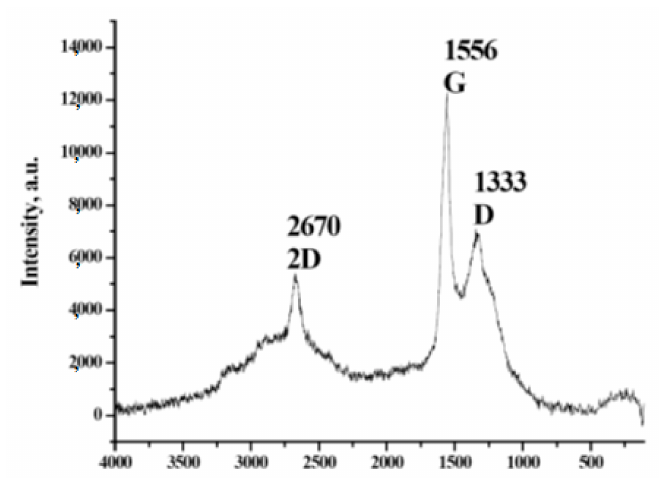
Figure 4. Raman spectrum of carbonized carbon foam.